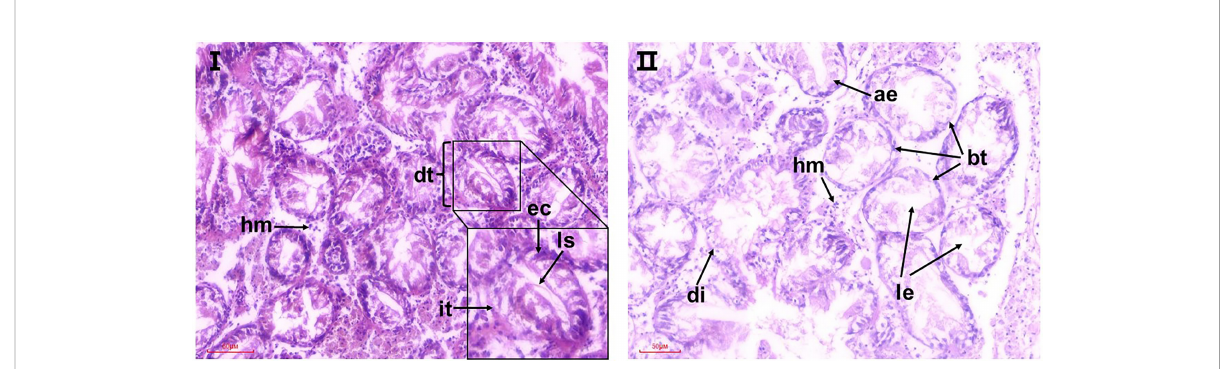
FIGURE 5 Representative micrographs of observed histopathological alterations in the digestive glands of razor clams after 35 days of exposure to seawater acidi fi cation. I: the pH 8.1 group; II: pH 7.7 group; dt, digestive tubules; it, interstitial tissue; ec, epithelial cell; ls, luminal stenosis; le, luminal enlarged; hm, hemocyte. ae, atrophy of epithelial cells; bt: basement membrane of epithelial cells became thin; di, diffuse digestive